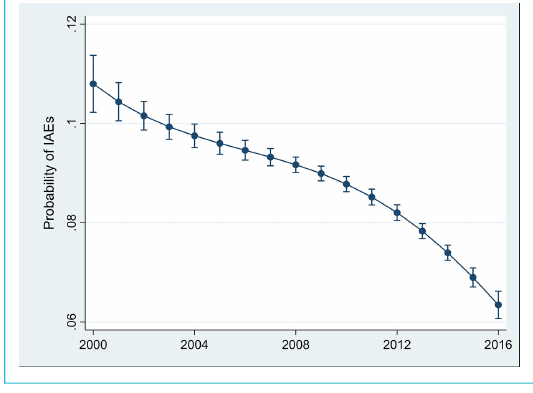
Figure 1: Marginal probability of overall IAE occurrence in ambula- tory anaesthesia between 2000 and 2016.Notice that the origin of the y-axis does not start at 0.